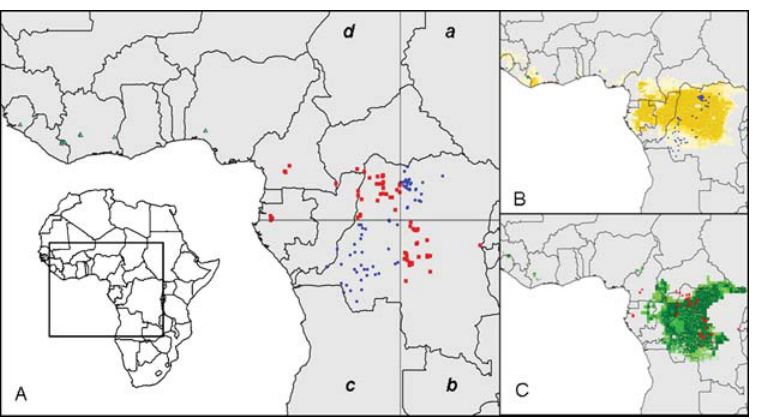
Figure 3. Summary of quadrant analyses of model robustness. (A) Central African human monkeypox occurrences divided into quadrants above and below the median longitude and latitude. (B) Modeled distribution created using only off-diagonal ( b/d , red circles) input data. (C) Modeled distribution created using only on-diagonal ( a/c , blue circles) input data. Darker shades indicate areas with greater model agreement in predicting area as suitable for monkeypox. Human monkeypox occurrence locations indicated by triangles were not used in model construction.